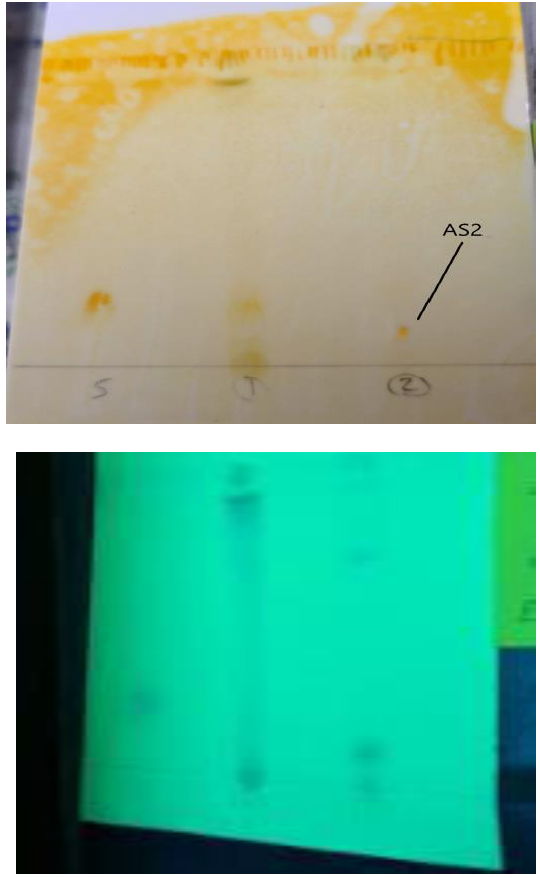
Figure 2. TLC for chloroform fraction before basify (1), after basify (2) and pseudoephedrine standard (S) developed with A2 solvent system, at 254 nm and after Dragedorff,s spray reagent.